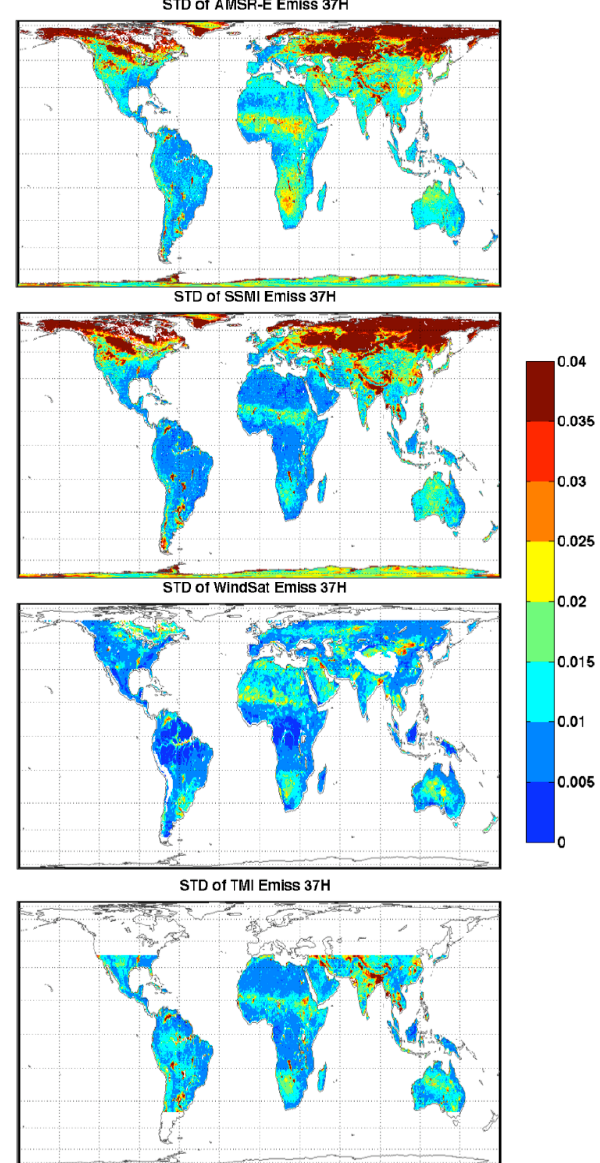
Figure 2. Monthly standard deviation of emissivity estimates from AMSR-E, SSM/I, WindSat, and TMI from 2003 to 2007 at 37GHz (horizontal polarization).